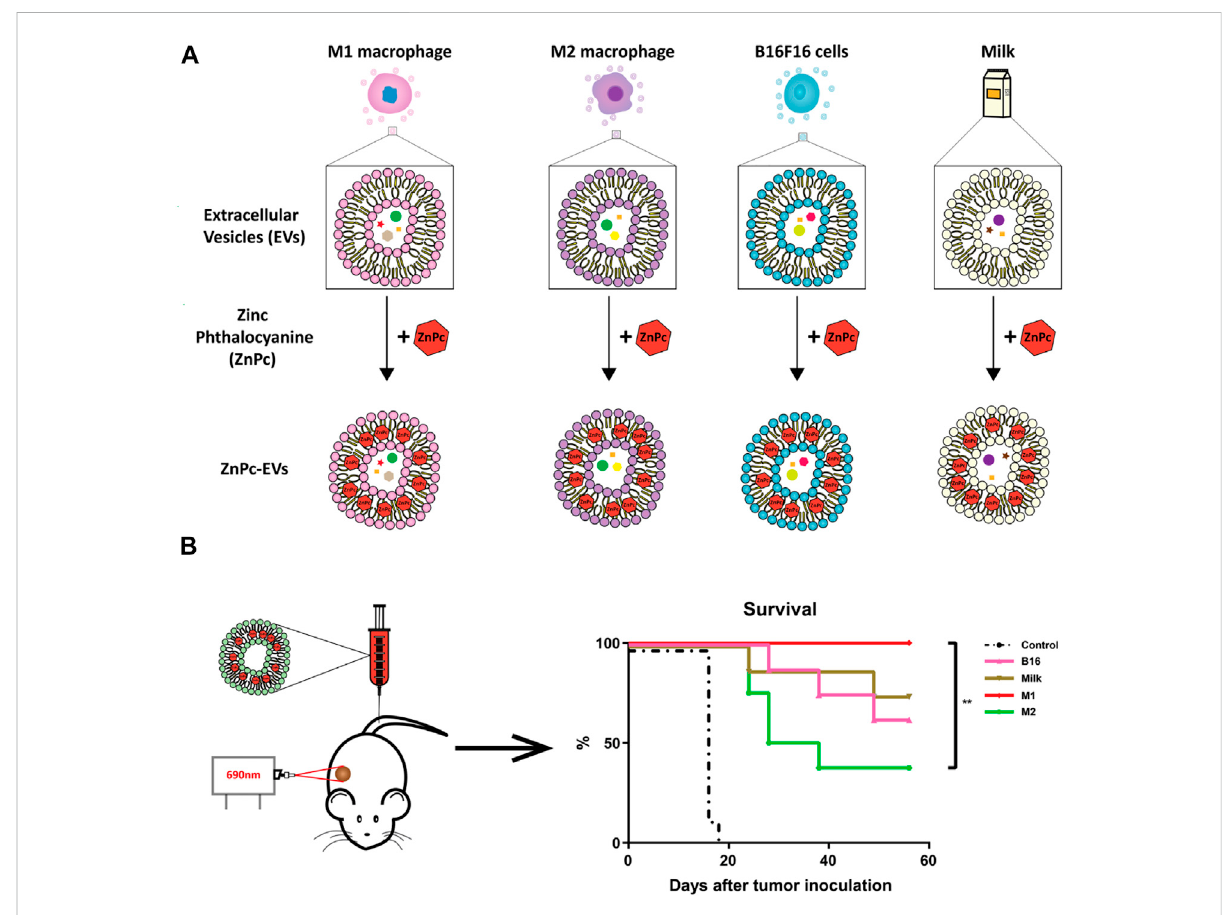
FIGURE 3 EVs from multiple cell sources as photosensitizer carriers for photodynamic therapy. (A) ZnPc was incorporated into EVs derived from immune cells (M1 or M2 like macrophages), cancer cells (B16F10 melanoma cancer cells), or external sources (milk), by a direct incubation strategy. (B) Therapeutic ef fi cacy of photosensitizer-based delivery systems in cancer (Huis In ’ t Veld et al., 2022). Copyright 2022